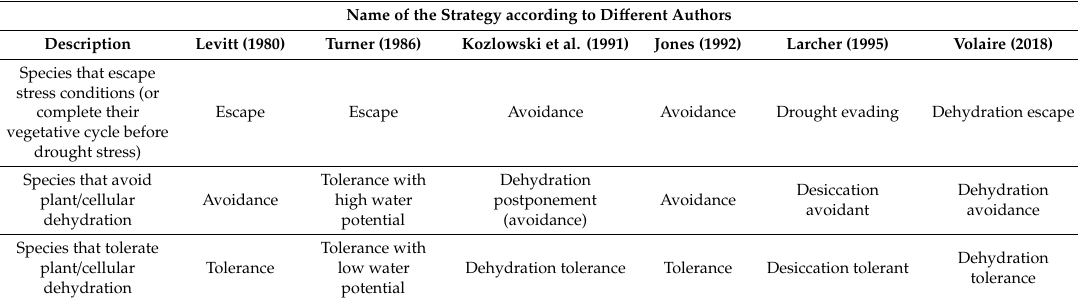
Table 1. Nomenclature of strategies for coping with drought. The response of plants to water deficit has been classified and named in various ways according to the di ff erent authors, although many of them are equivalent. The equivalences of the most used terms and classifications are shown here. From Valladares et al. [45] with